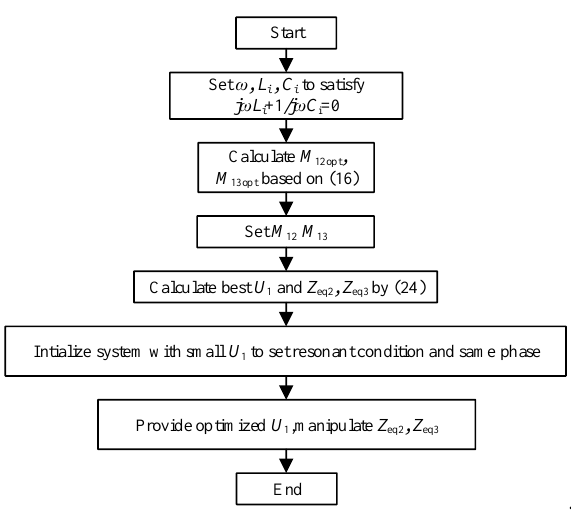
Figure 5. Flowchart of system control program.